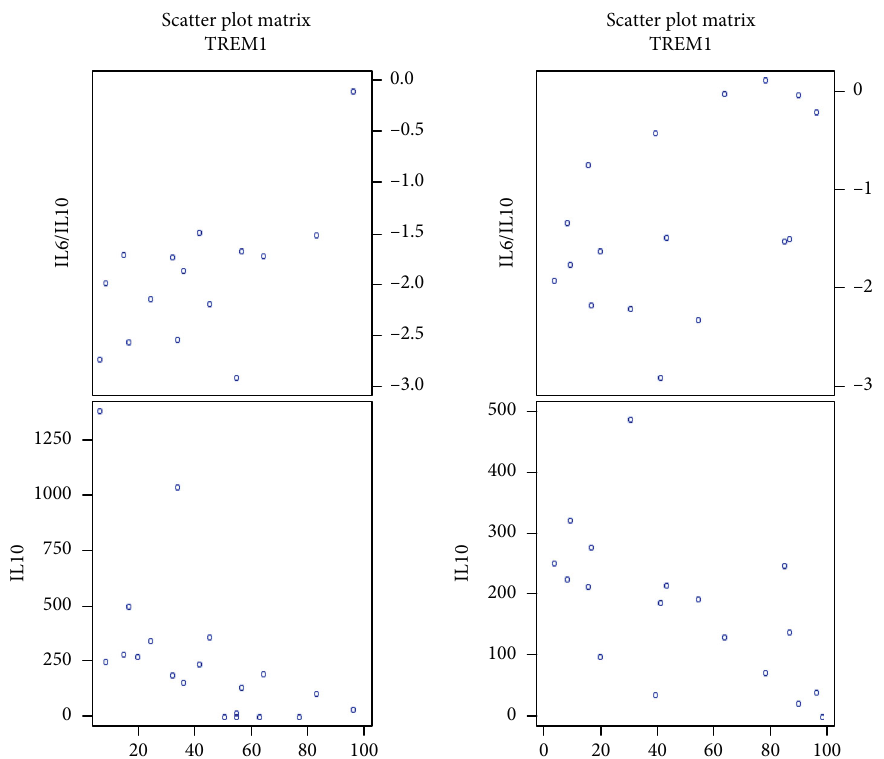
Figure 10: Scatter plots showing correlations of CD14 + TREM-1 + cell percentage with IL-6/IL-10 ratio and with IL-10 in grade II (on the left side) and in grade IV (on the right side) (data log